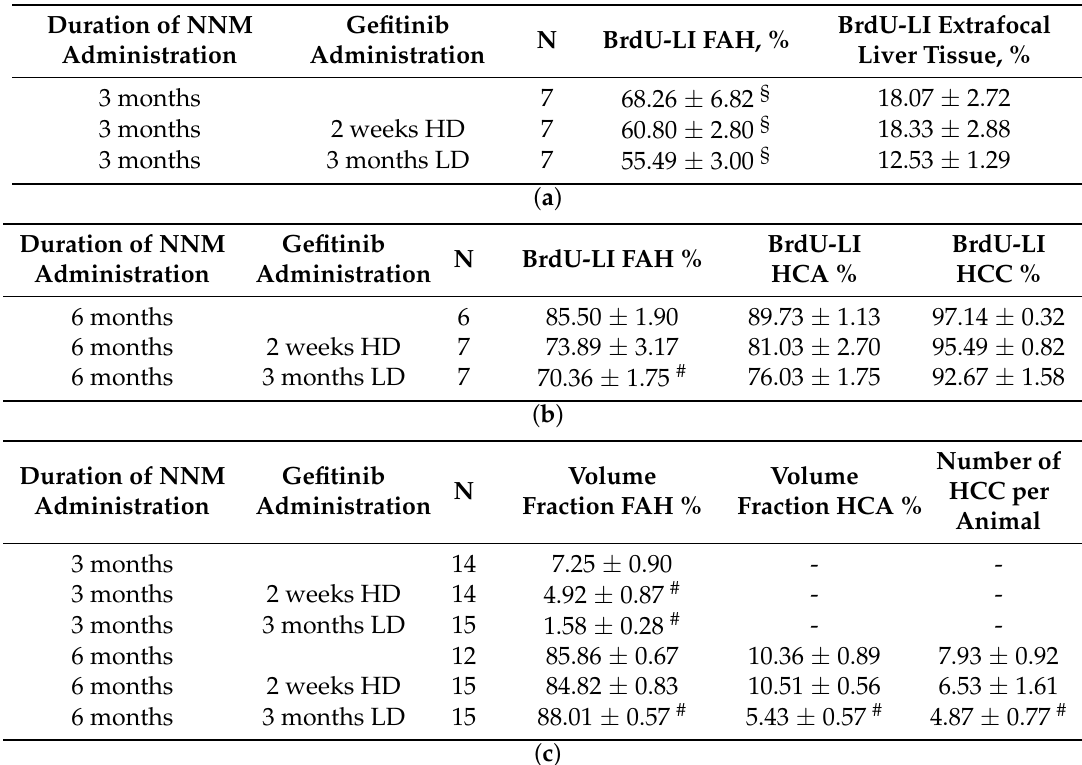
Table 1. The effect of gefitinib treatment on the proliferative activity of pre-neoplastic liver lesions and extrafocal liver tissue ( a ); proliferative activity ( b ); and quantity ( c ) of hepatocellular tumors in chemical hepatocarcinogenesis with N